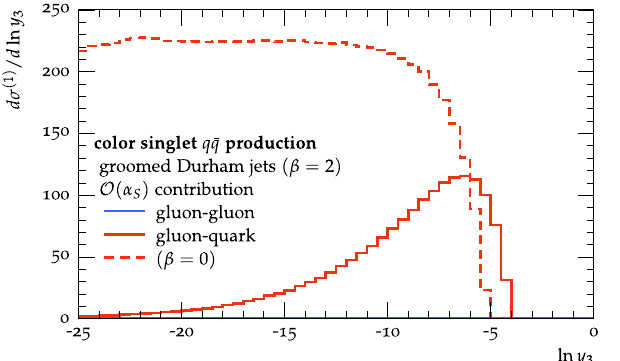
Fig. 3 NLO (left) and NNLO (right) contributions to the cross sec- tion as a function of the y 3 jet resolution of the event, for different assignments of flavour to the two jets obtained from Durham cluster- ing, according to the jet constituents after SD grooming with β = 2